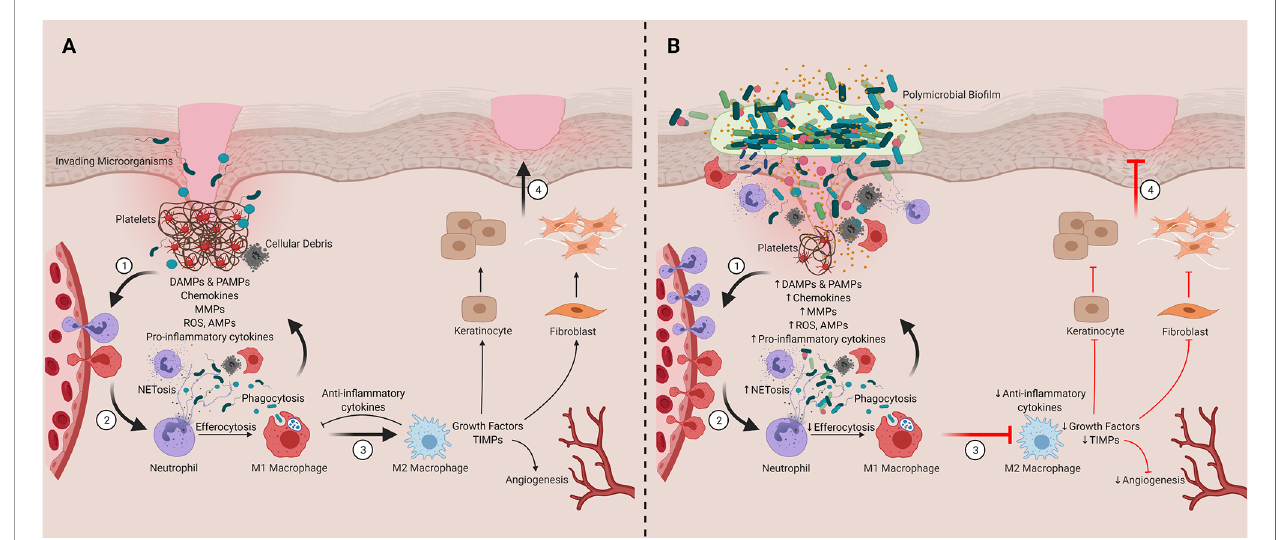
FIGURE 2 | Contribution of innate immune cells and in fl ammation to timely and delayed wound healing. (A) Representation of the four phases of wound healing ([1] Hemostasis, [2] In fl ammation, [3] Proliferation and [4] Tissue Remodeling). (B) Chronic wounds are stalled in the in fl ammatory stage. We hypothesize that this in fl ammation is sustained by chronic activation of the innate immune system, which is driven their interactions and responses to polymicrobial bio fi lms found in and on the wound bed. DAMPs, damage-associate molecular patterns; PAMPs, pathogen-associated molecular patterns; MMPs, matrix metalloproteinases; ROS, reactive oxygen species; AMPs, antimicrobial peptides; TIMPs, tissue inhibitor of metalloproteinases. Created with